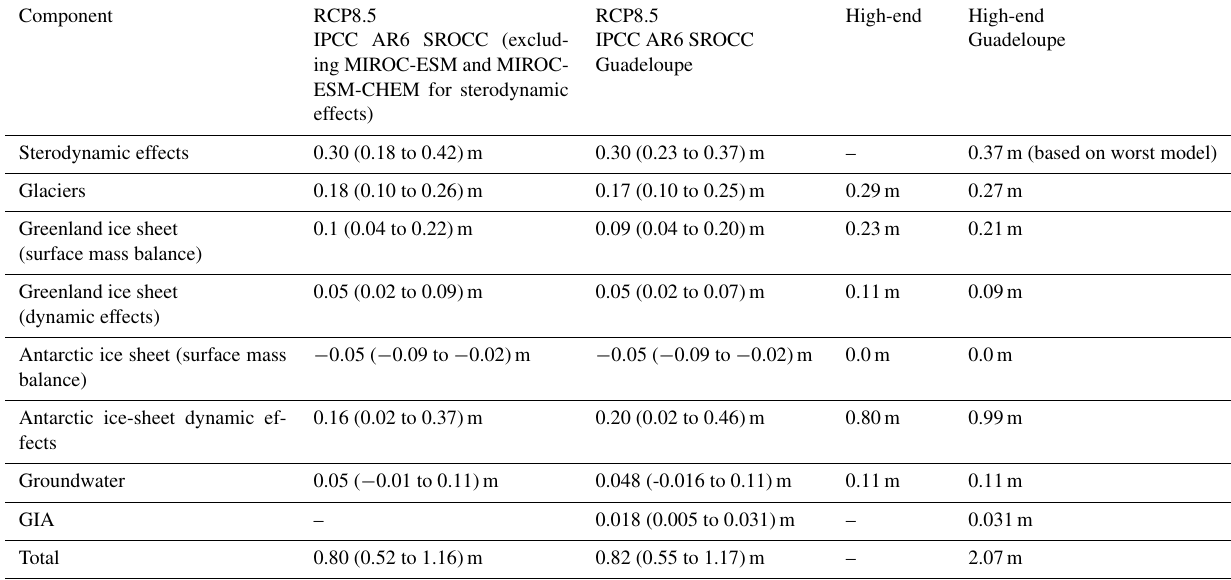
Table 1. Assumptions for global mean contributions to sea-level changes by 2100 relative to 1986–2005 for the AR6 SROCC median and likely range (in parentheses) and for our high-end scenario and its implications in Guadeloupe. (See Thiéblemont et al., 2019). Note: the likely range of the sum is not equal to the sum of the likely range due to dependencies between components (Church et al., 2013a; Le Bars, 2018). We extract Guadeloupe data at the following coordinates: 16 ◦ N, 61 ◦ W. The computation of the total uses the same dependency schemes as the regional approach of Church et al. (2013a), which, together with the choice to remove MIROC-ESM and MIROC-ESM-CHEM models, accounts for differences with the data published in SROCC (Oppenheimer et al., 2019).